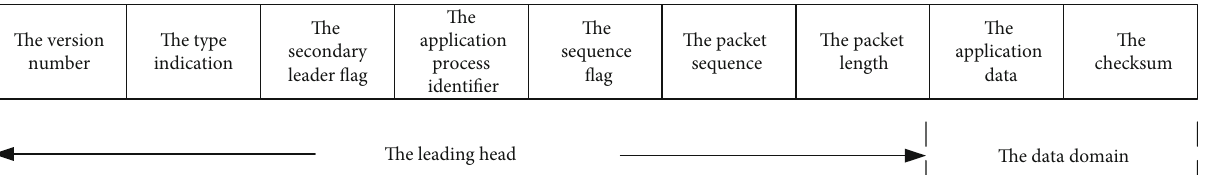
Figure 4: Format of multibyte data.